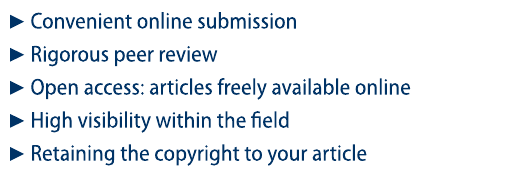
Table of normal values. In: Williams A (ed) Manual of Hematology, 9th edn. McGraw Hill, New